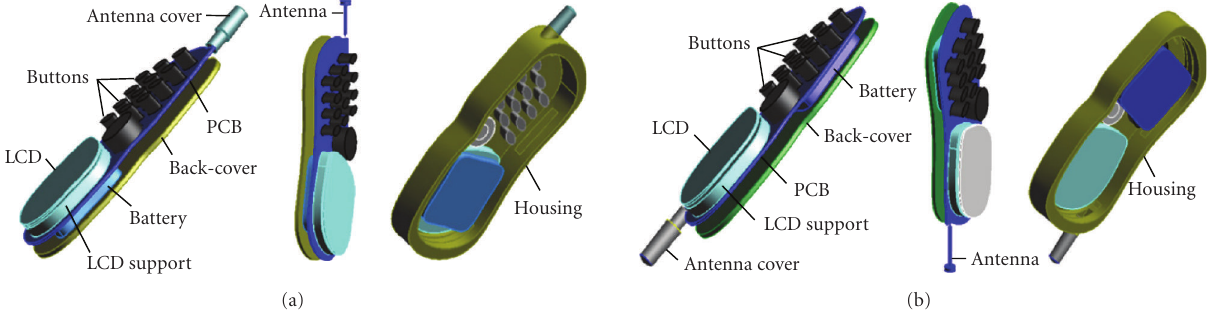
Figure 3: Numerical components structure of (a) the handset model no. 1, and (b) the proposed handset model no. 2.